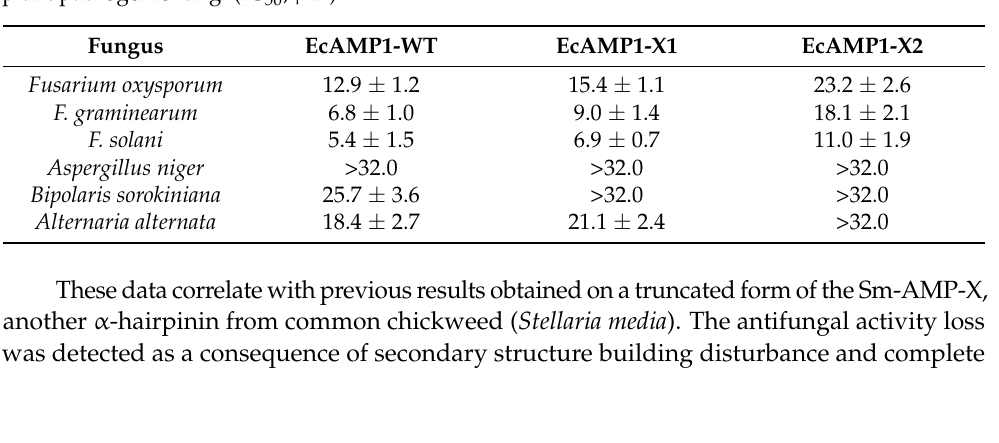
Table 1. Antifungal activity of the native and the truncated forms of EcAMP1 according to a panel of plant pathogenic fungi (IC 50 , µ